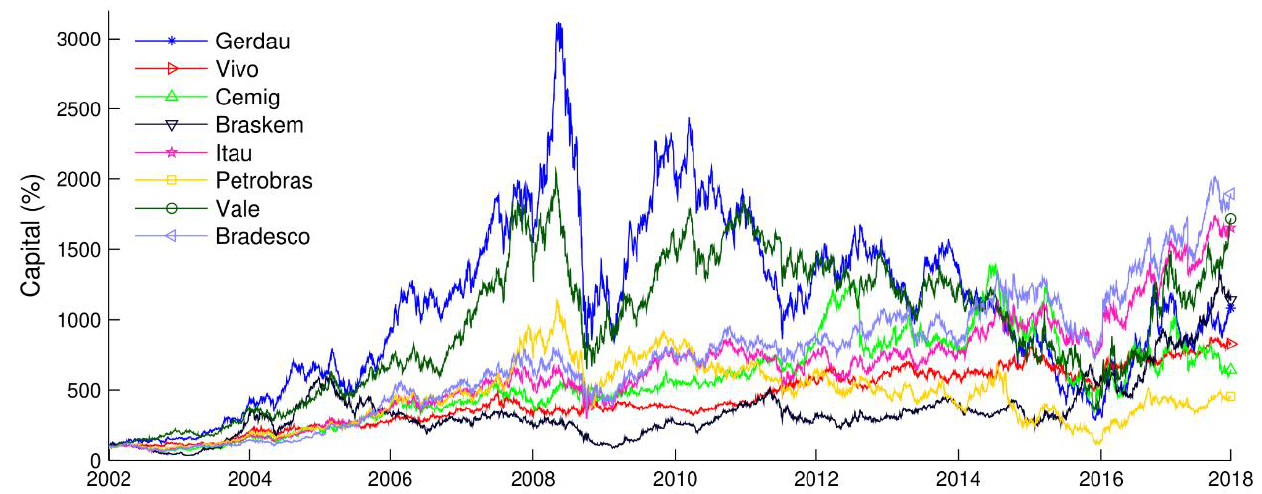
Figure A1. Capital cumulative curves of the securities used in this study. Table A1. Statistics of the returns, N = 3961: Asymmetry (Asym.), Kurotsis (Kurt.), Jarque-Bera (JB) test. β is the Fama–French three-factor model (FF3) market beta, and S is the Sharpe ratio.